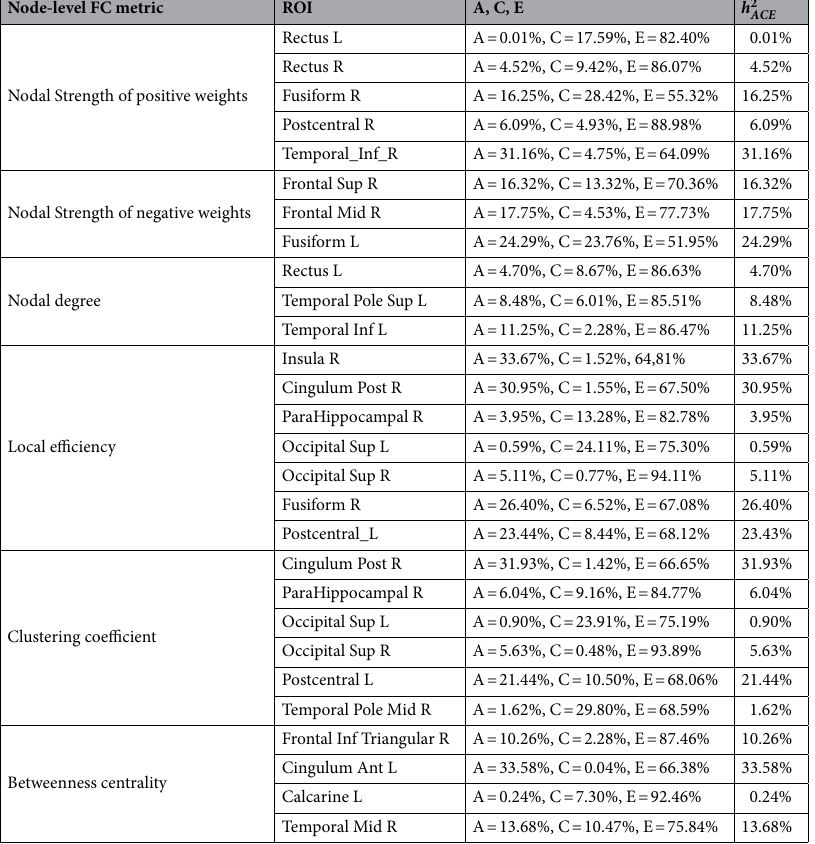
Table 4. Location of ACE factor influences on node-level FC metrics reported for each ROI in which ACE model was applicable, and the corresponding ACE coefficients and “narrow-sense” heritability estimates. Orb, orbital part; inf, inferior part; mid, middle or median part; sup, superior part, r, right; l, left; post, posterior part; ant, anterior part. h 2 ACE : “narrow-sense” heritability estimate.